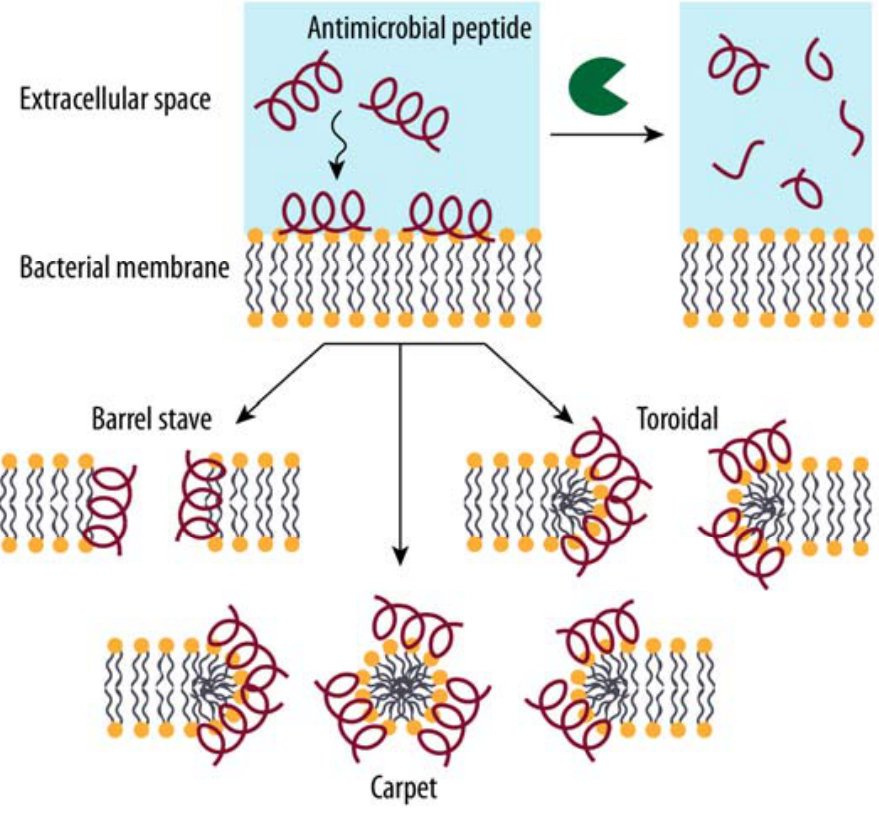
Figure 4. Models of lipid membrane disruption by antimicrobial peptides. Antibacterial peptides are first adsorbed to the membrane surface. Once a certain threshold is reached, membrane disruption occurs. In the barrel-stave model, the peptides are aligned parallel to the phospholipids of the bacterial membrane, generating a continuous barrel-like pore. In the toroidal pore model, a similar hydrophilic transmembrane channel is created, but with the lipid moieties folding inwards, and the hydrophilic phospholipid heads participate in channel formation. In the carpet model, accumulated peptides break down the lipid bilayer in a detergent-like manner into micelle-like structures surrounded by the peptides. Importantly, secreted bacterial proteases, indicated as green Pacman shapes, can cleave and hence inactivate antimicrobial peptides. Figure adapted from [77,79]. However, just as vertebrates have developed various defense mechanisms, pathogens have evolved multifaceted strategies to avoid or inactivate both the adaptive and the innate immune system to ensure their survival and spread to different sites within a host, such as by changing their proteins on the surface, or by secreting proteases that can target antibodies, complement factors, or AMPs. For example, by cleaving antibodies between the Fab and Fc regions, the recognition and effector domains of the antibody are separated, inhibiting downstream signaling and thus allowing bacteria to stay undetected, leading to enhanced bacterial survival. Moreover, numerous bacterial proteases have been shown to cleave and neutralize antimicrobial peptides (Figure 4, top right) or to inactivate various components of the complement cascade, hence preventing not only the assembly of the membrane attack complex, but also deterring the recruitment of immune cells to the site of infection